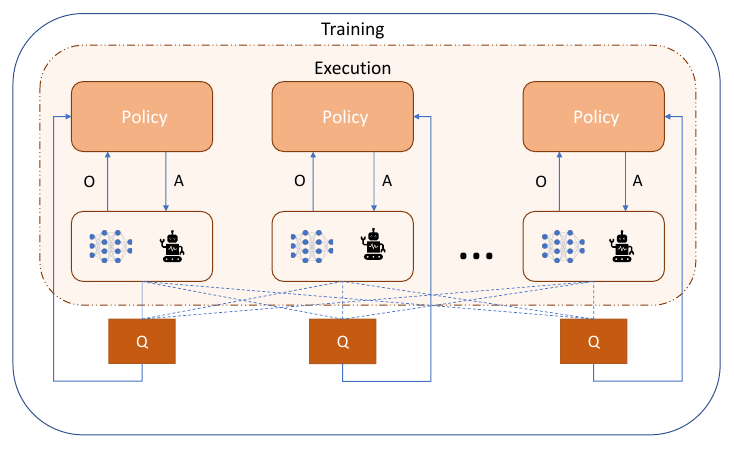
Figure 4. Illustration of multi-agent DDPG (MADDPG) [61].